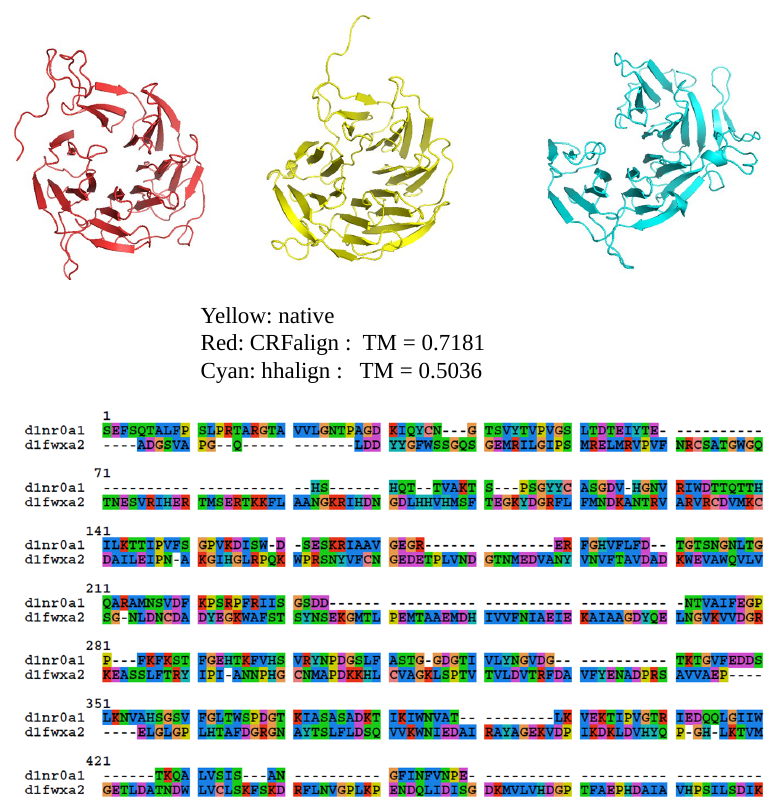
Figure 6. Structure models of d1nr0a1 (C.elegans actin-interacting protein1 Seven-bladed beta-propeller domain) based on d1nr0a1-d1fwxa2 alignment (Reference TM = 0.75381, ID = 9.4%) from CRFalign ( top left , red) with TM-CRFalign = 0.7181, and HHalign ( top right , cyan) with TM-HHalign = 0.5036; at the to center (yellow) is the native structure. The bottom figure shows the CRFalign pairwise alignment where a few large gaps are recognized for proper